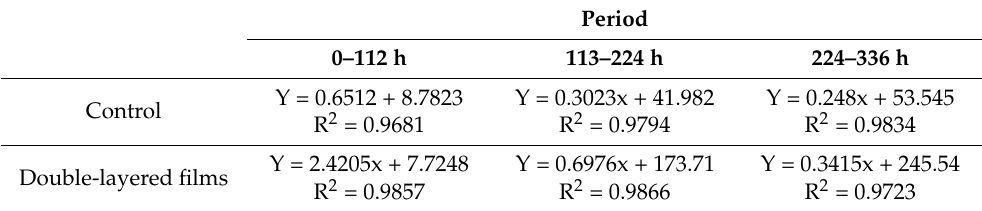
Table 2. Equations of respiratory activity for incubated materials over 3 equal periods covering 14 days (mg CO 2 ÷ g h)